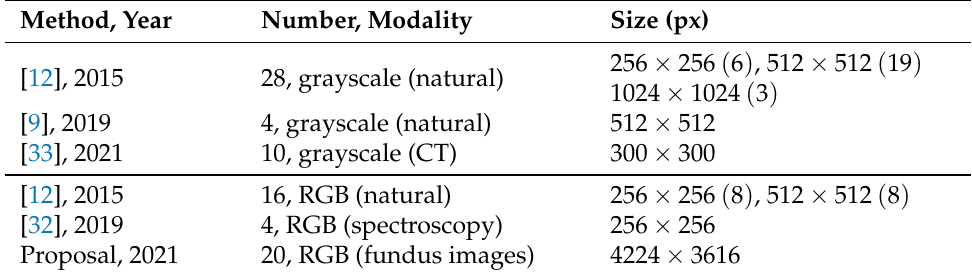
Table 2. Main modalities and differences of the image datasets used by the authors to be compared. Method,